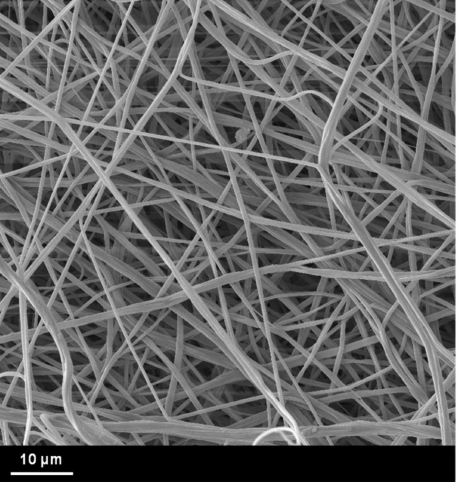
Figure 7. SEM image of the PVDF-TrFE